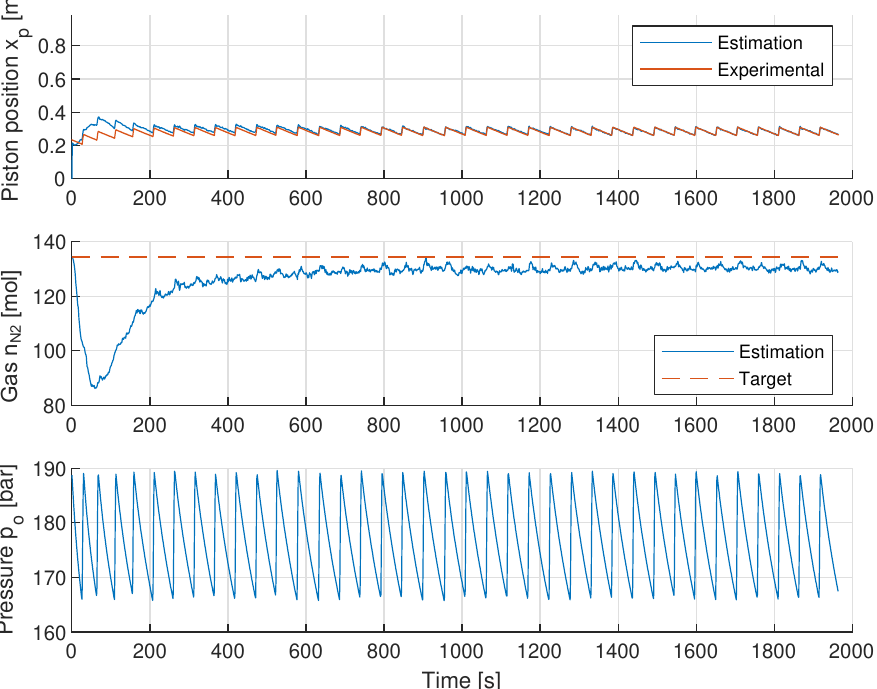
Figure 9. Estimated and experimentally measured piston position and molar value of gas for the low-load test sequence. The accumulator is pre-charged to 125 bar/134 mol.